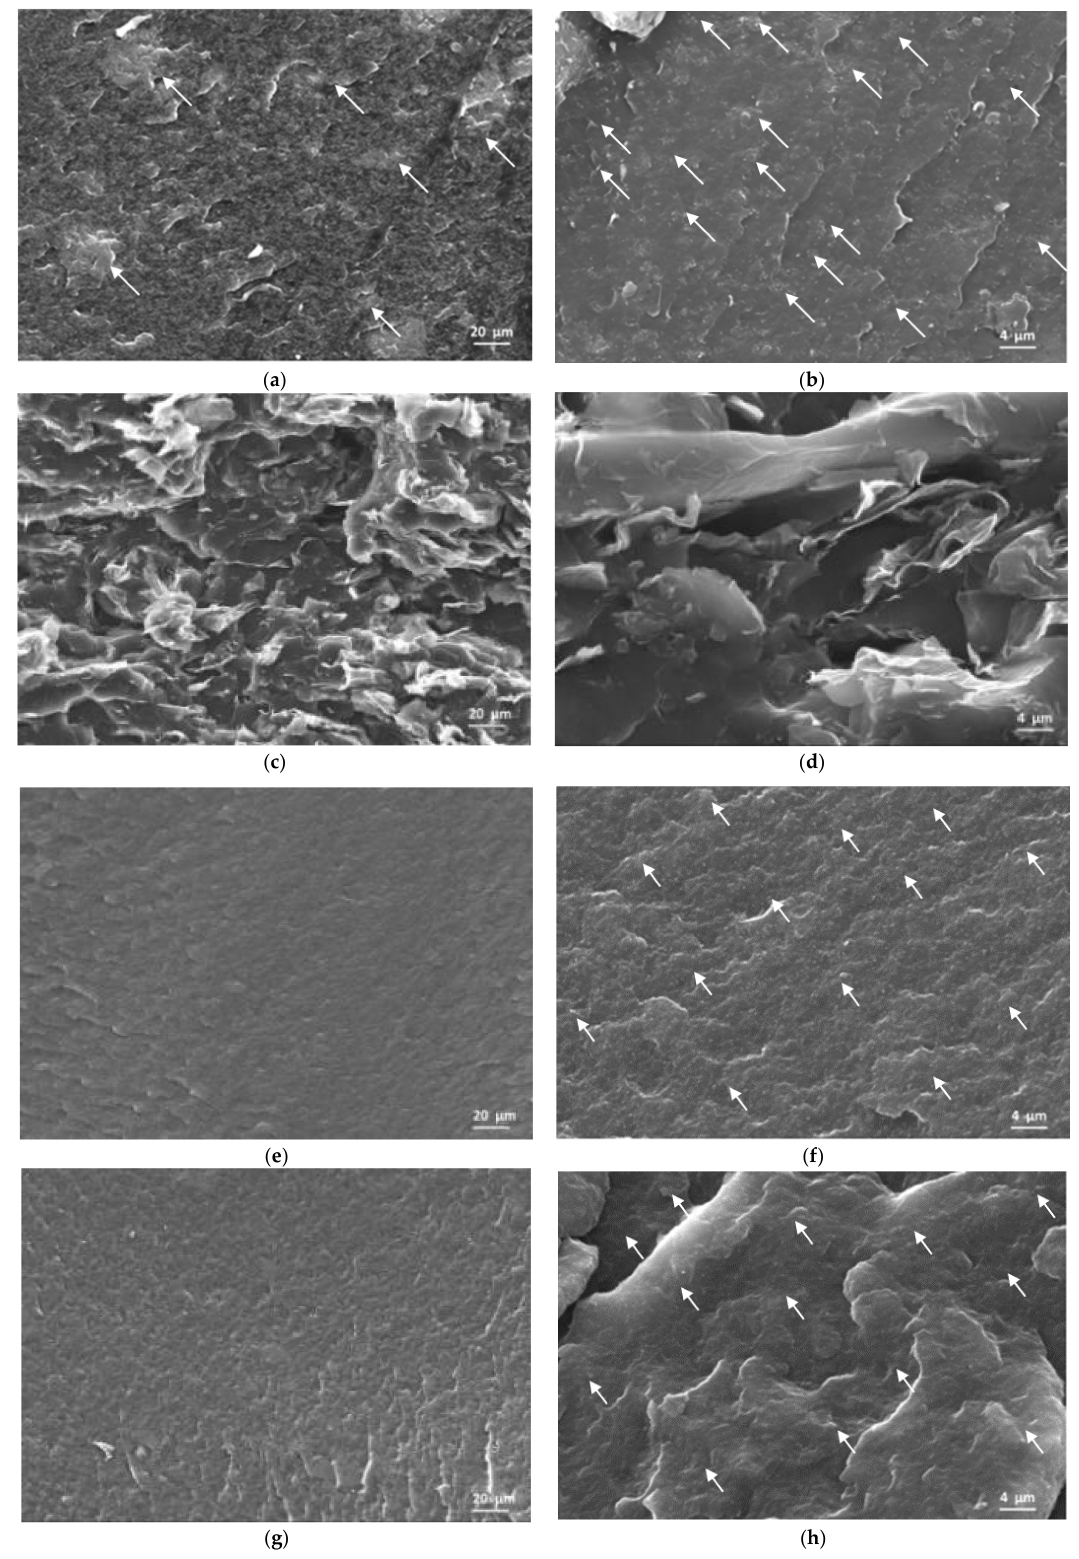
Figure 5. Scanning electron microscopy of ( a ) 5 wt% MWCNT (1.0 × magnification), ( b ) 5 wt% MWCNT (5.0 × magnifica- tion), ( c ) 15 wt% EG (1.0 × magnification), ( d ) 15 wt% EG (5.0 × magnification), ( e ) 17.5 wt% CB-65 (1.0 × magnification), ( f ) 17.5 wt% CB-65 (5.0 × magnification), ( g ) 10 wt% CB-770 (1.0 × magnification), ( h ) 10 wt% CB-770 (5.0 × magnifica- tion),